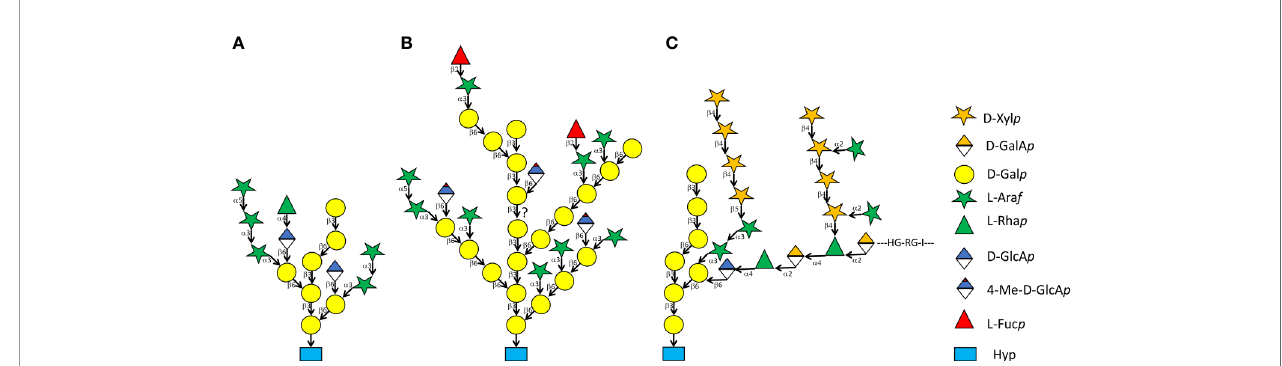
FIGURE 1 | Three variants of type II AG. Structure (A) was determined from the synthetic AGP (Ala-Hyp)51-EGFP expressed in and secreted from Nicotiana tabacum Bright Yellow 2 suspension cells (Tan et al., 2004). Among other techniques, the Hyp-glycan was analyzed using nuclear magnetic resonance spectrometry. Structure (B) is one of many possible models derived from enzymatic fragmentation and electrophoretic as well as mass spectrometric analysis of AGP bulk-puri fi ed from A. thaliana leaves (Tryfona et al., 2012). Stucture (C) shows a type II AG sub-structure linked to APAP1/AGP57C and to arabinoxylan and pectic rhamnogalacturonan I (Tan et